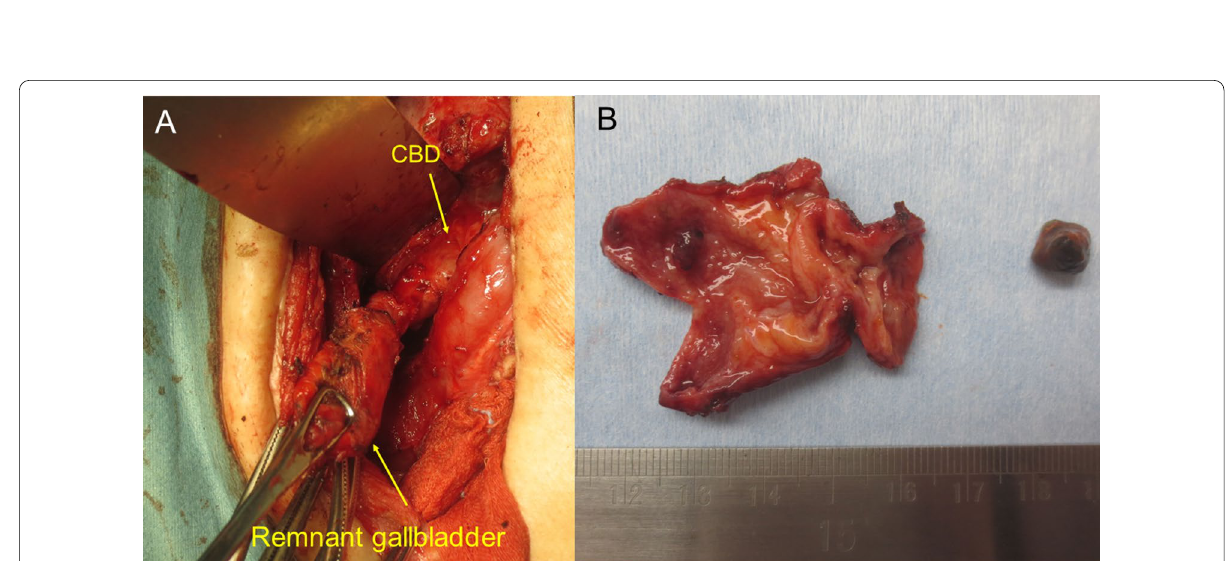
Fig. 3 Case 2. a Plain abdominal computed tomography showed remnant gallbladder (47 abdominal wall (arrow head). b A small stone was found in the cystic duct (arrow). c The EBS and EGBD tubes were placed in the common bile duct